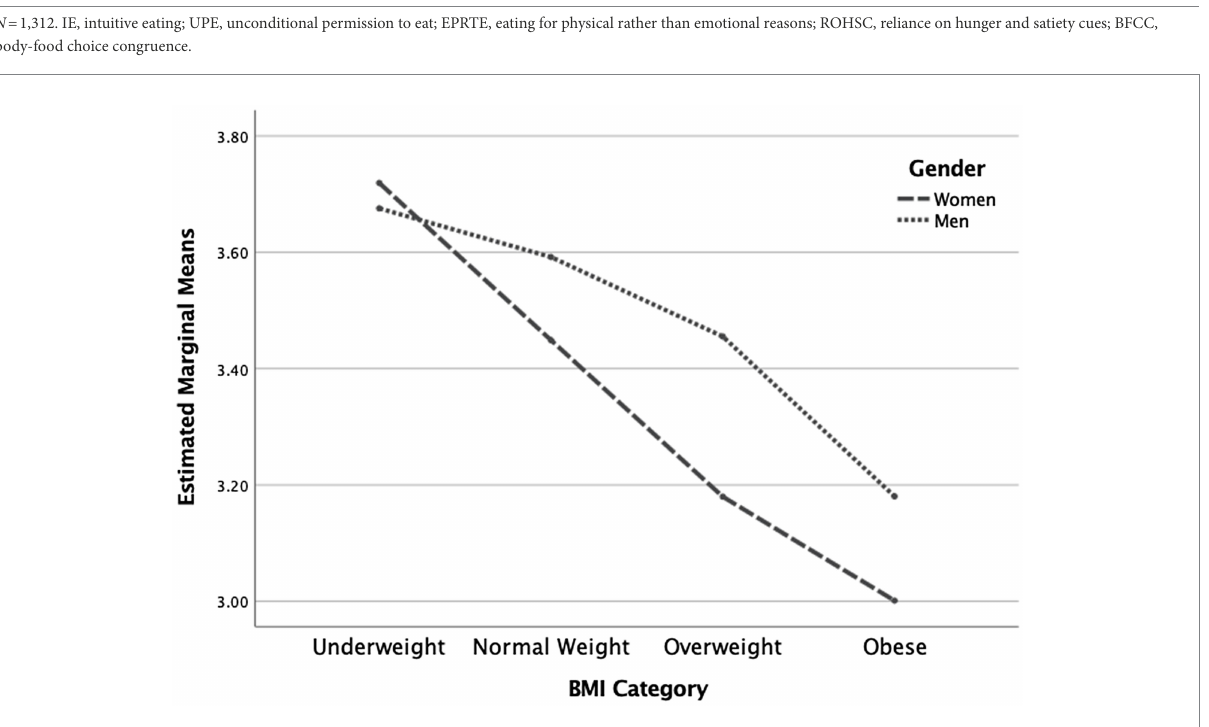
FIGURE 1 Interaction effect for intuitive eating total score. N = 1,312 ( n = 657 for women, and n = 655 for men), p <